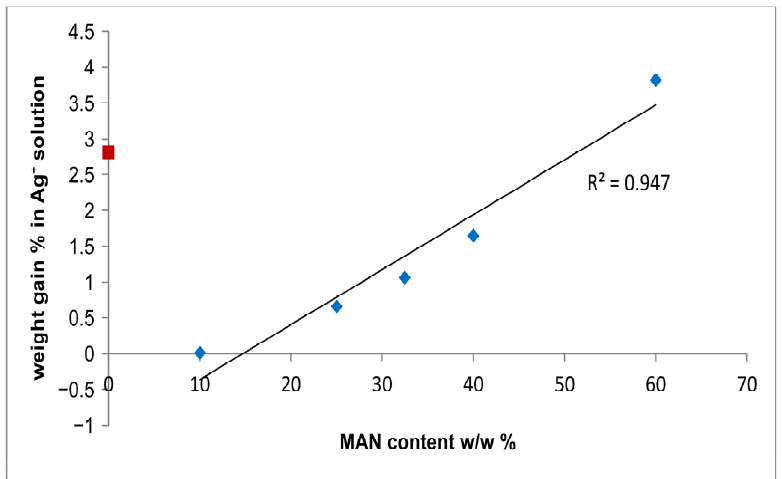
Figure 9. Trend of the % weight gain of the fibers due to Ag + uptake as a function of the MAN content ( w / w %). The silk fibroin control sample is indicated with a red square because it was not used to calculate the regression line.